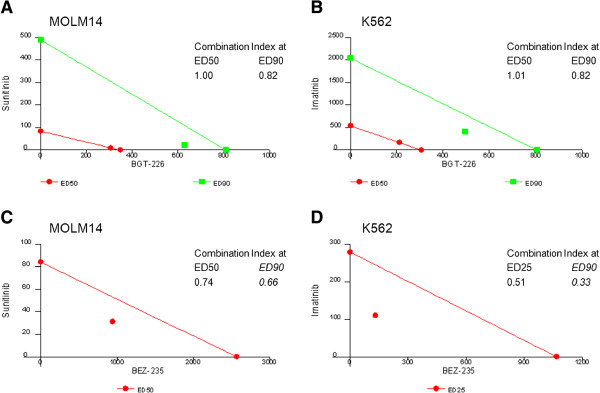
Isobologram analyses of combined dual PI3K/MTOR plus TKI treatment in mutant-TK activated leukemia cells. Co-treatment of specific TKI (sunitinib to target FLT3 ITD in MOLM14 cells (A and C), imatinib to target BCR-ABL1 in K562 cells (B and D) with either NVP-BGT226 (A and B) or NVP-BEZ235 (C and D) reveal additive to synergistic proapoptotic effects for the combination treatment: Isobolograms are provided, showing experimental points that fall on or below the predicted line of additive effect, indicating additive to superadditive effects for all tested endpoints. Calculations of combination indices (CI) provide a mathematical number to describe the degree of synergy for the respective endpoint.